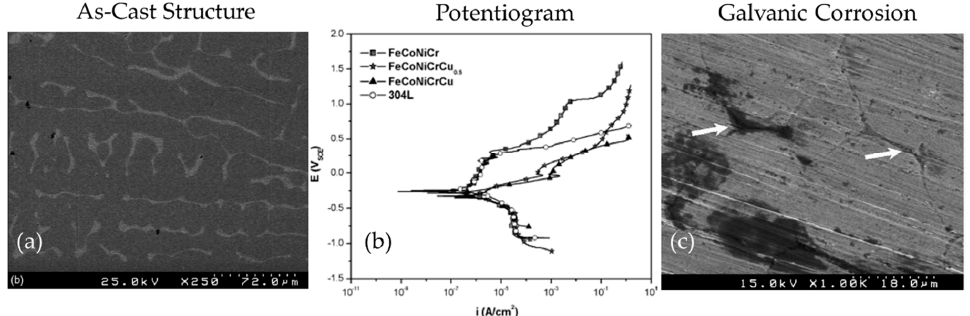
Figure 2. ( a ) As-cast microstructure of CoCrFeNi-Cu alloy showing dendritic microstructure. The copper rich interdendritic regions appear white, while the dendrites are darker; and, ( b ) Potentiodynamic polarization plots of the alloys in 3.5% NaCl. The Cu free CoCrFeNi alloy showed highest resistance compared to other two complex concentrated alloys (CCAs) and SS304L; ( c ) Microstructure after corrosion tests showing that Cu rich inter-dendritic regions corroded faster as compared to the dendritic regions lean in Cu. This may be due to the galvanic effect arising from the difference in composition [29] (reprinted with permission from